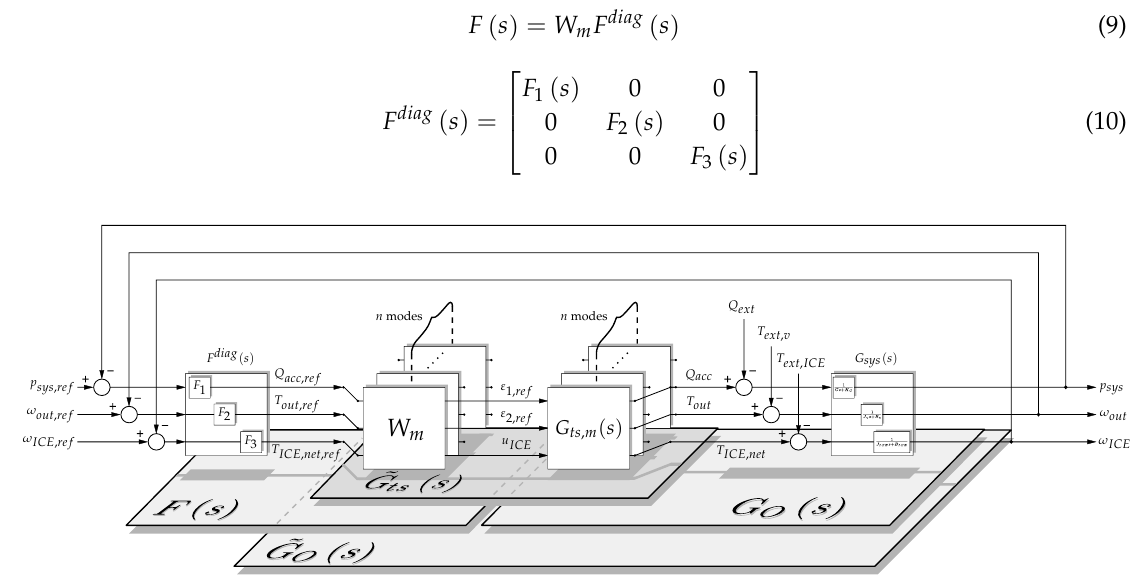
Figure 3. Schematic overview of a decoupled MIMO control approach for a complex hydraulic hybrid transmission with n